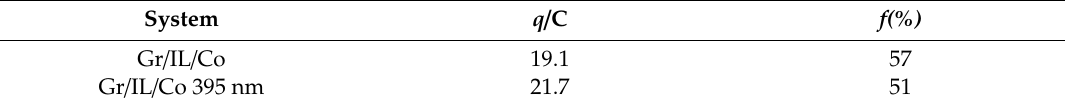
Table 5. q and f(%) values for the systems Gr / IL / Co and Gr / IL / Co 395